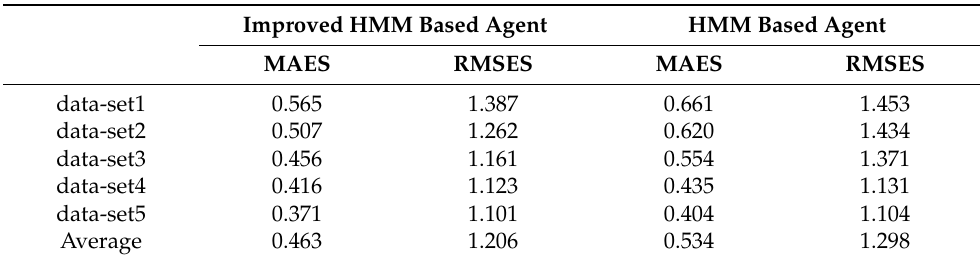
Table 2. HMM state prediction accuracy evaluation results.